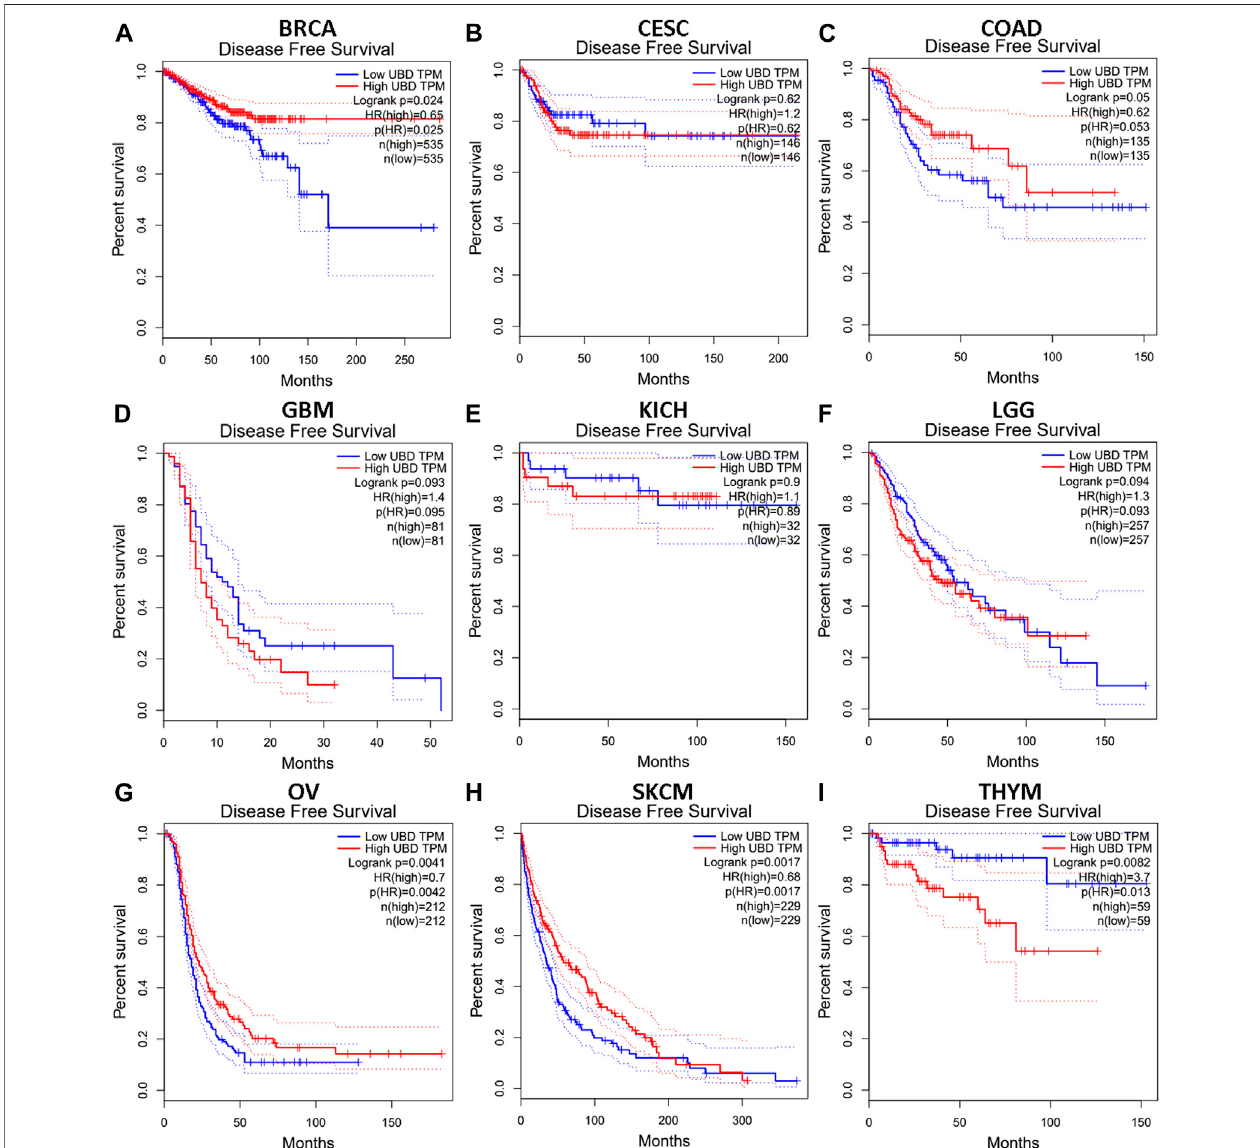
FIGURE3| The RFSanalysisforFAT10 invarioushuman cancersviaGEPIA database. (A – I) TheRFS plotofFAT10 inBRCA (A) , CESC (B) , COAD (C) , GBM (D) , KICH (E) , LGG (F) , OV (G) , SKCM (H) , THYM (I) .